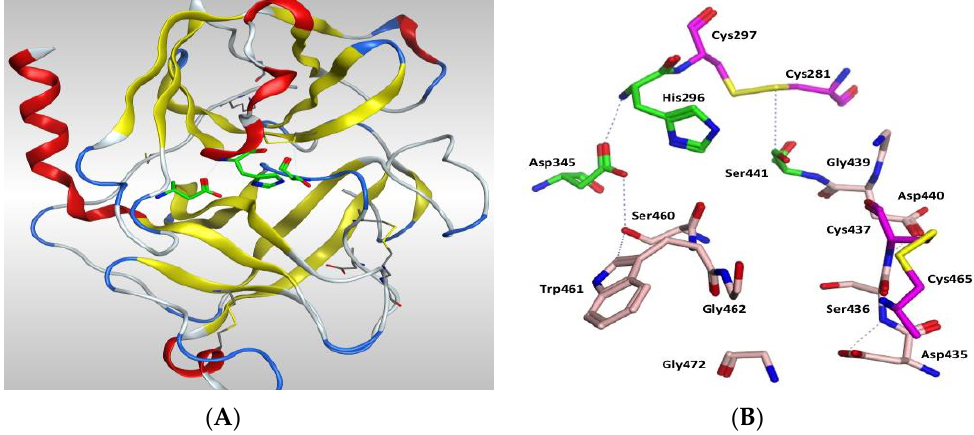
Figure 7. ( A ) 3D image of TMPS2 with the position of the catalytic triad (green) in the serine peptidase domain shown. The two six-stranded β-barrels (yellow) are positioned either side of the catalytic triad. ( B ) Serine peptidase active site showing the catalytic triad (green), the amino acids that form the S1 pocket (light pink) and the two disulfides Cys281-Cys297 and Cys437-Cys465 (magenta).